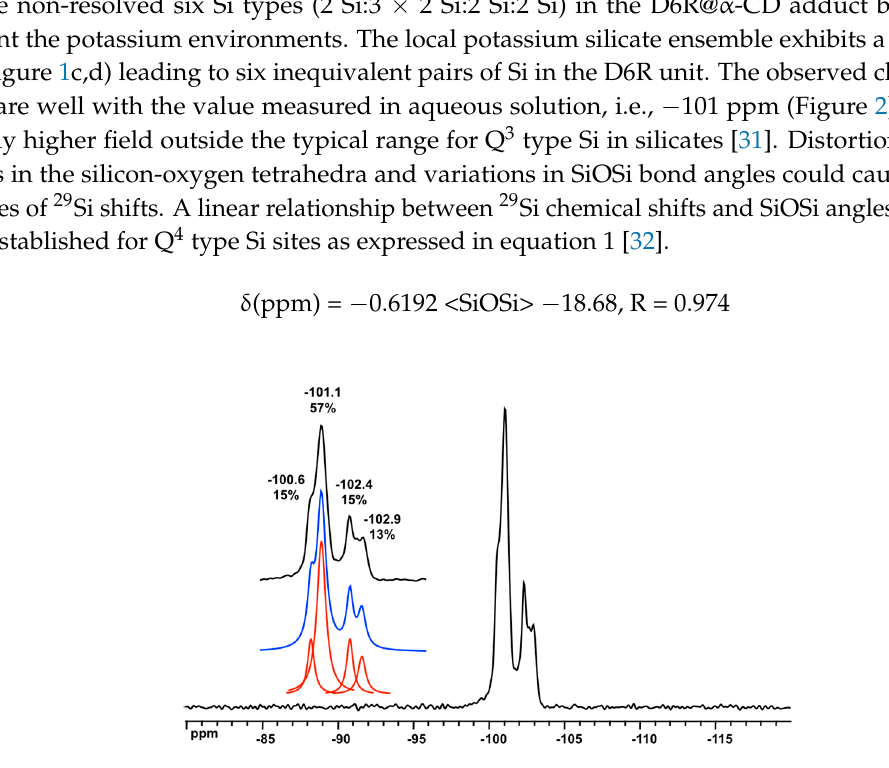
Table 3. Mean SiOSi bond angles in D n R silicate compounds and 29 Si NMR data. Environment Mean SiOSi (°) Average SiOSi (°) 29 Si (ppm)